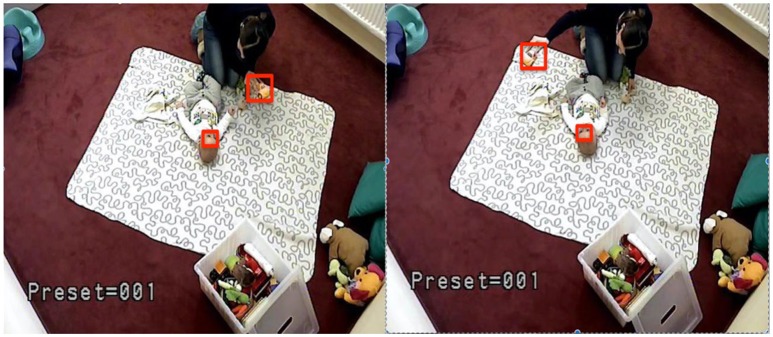
Example of how TLD was used to track the infant's focus of attention and the object that the mother held in front of the infant. The red bounding boxes represent these tracked features. Parents gave written consent to use the images in the publication.